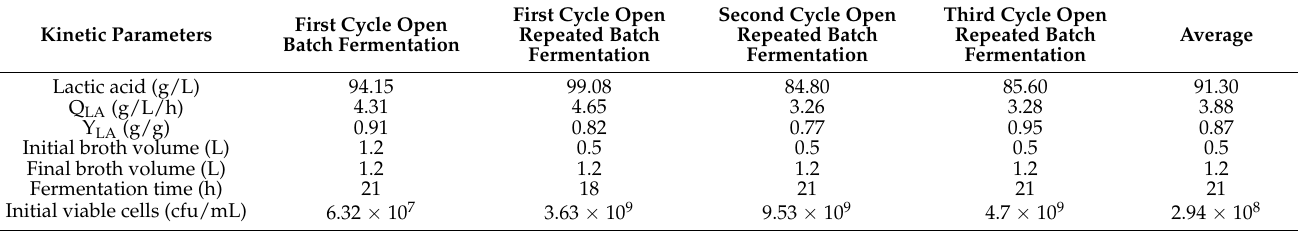
Table 2. Kinetics of open repeated batch fermentation of oil palm trunk sap by L. rhamnosus ATCC 10863.